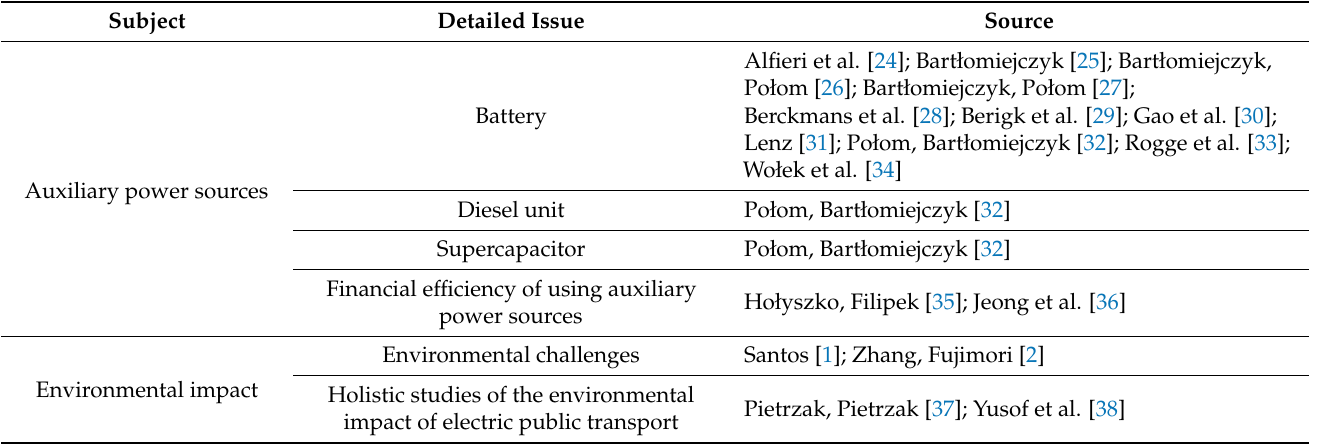
Table 1. Identification of research issues in the field of trolleybus transport (source: own